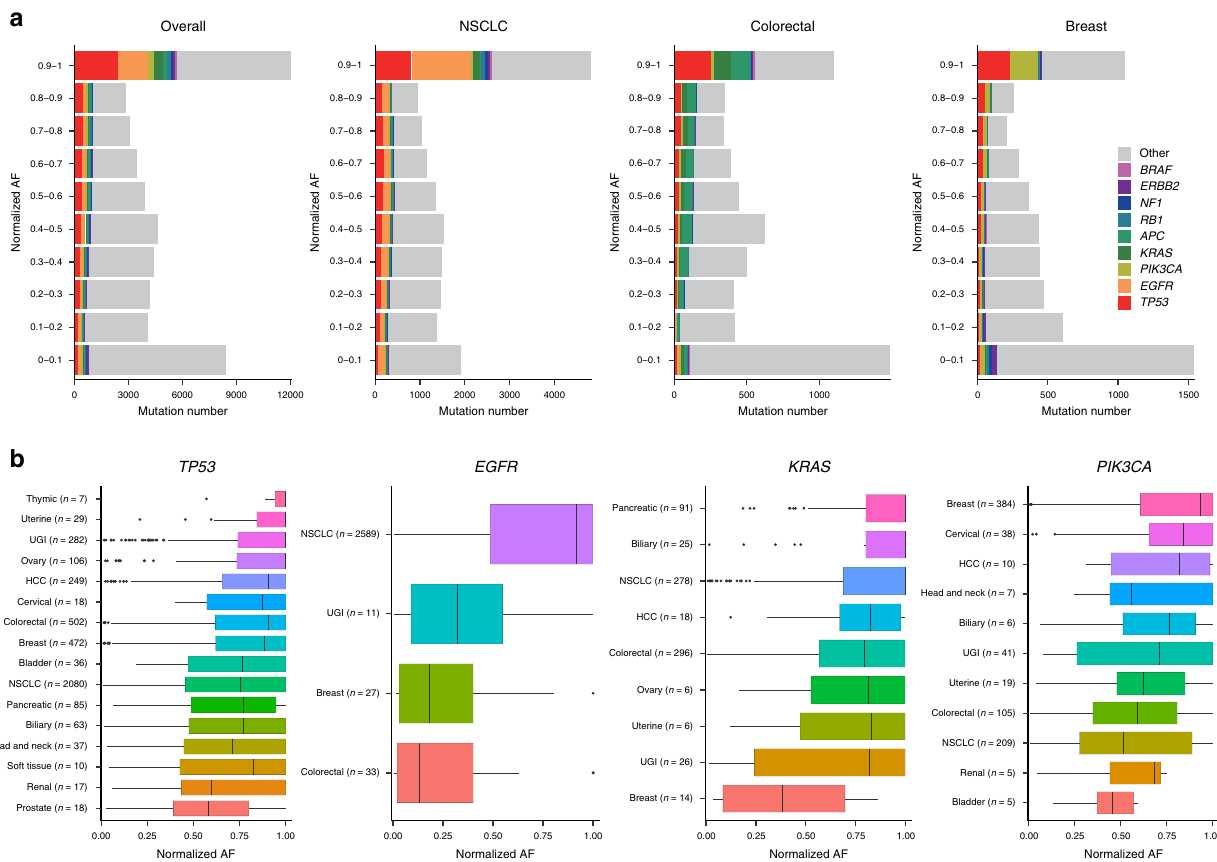
Fig. 5 Estimated ctDNA clonality is consistent with genomic characteristics of cancer subtypes. a Number of mutations with different ranges of clonality in the overall cohort, NSCLC, colorectal cancer, and breast cancer. Several common driver genes are highlighted with different colors and demonstrate shifts in fractions within different clonality ranges. b Clonality distribution of TP53 , EGFR , KRAS , and PIK3CA in different cancer types. In each panel, cancer types with fewer than fi ve speci fi c mutations ( TP53 , EGFR , KRAS , and PIK3CA ) are not shown. Centre line, median; box limits, upper and lower quartiles; whiskers, 1.5× interquartile range; points,